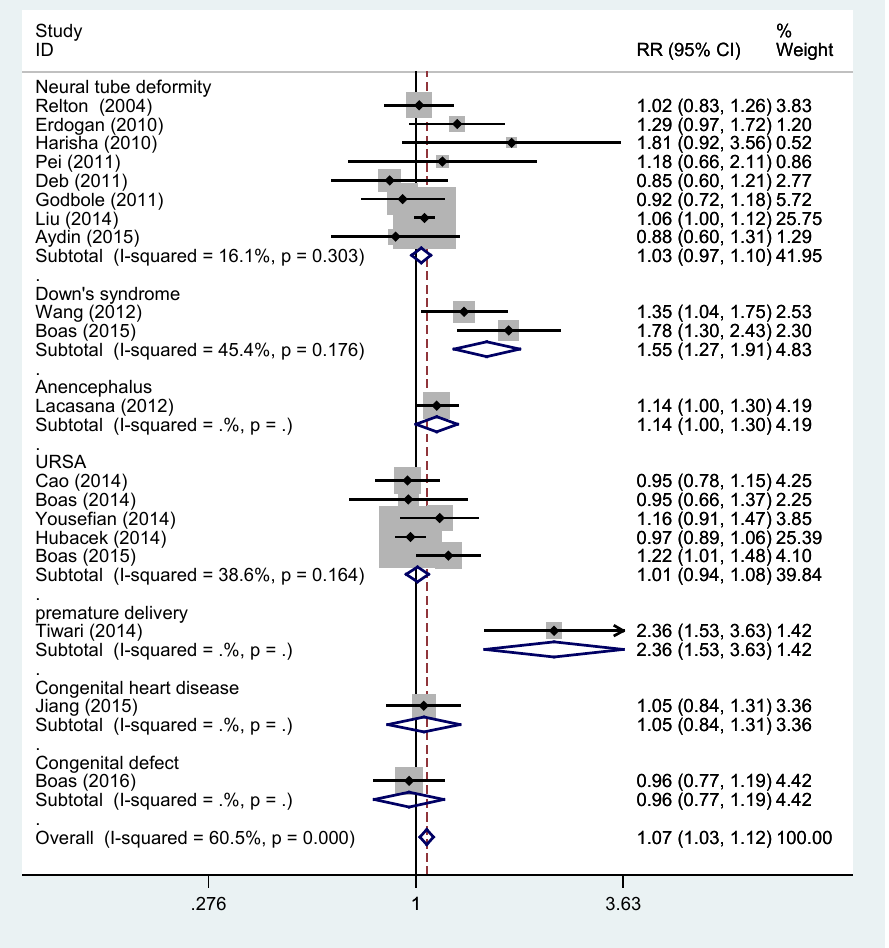
Figure 2: Forest plot of the methylenetetrahydrofolate reductase gene 677C > T polymorphism and fetal congenital defects in a dominant gene